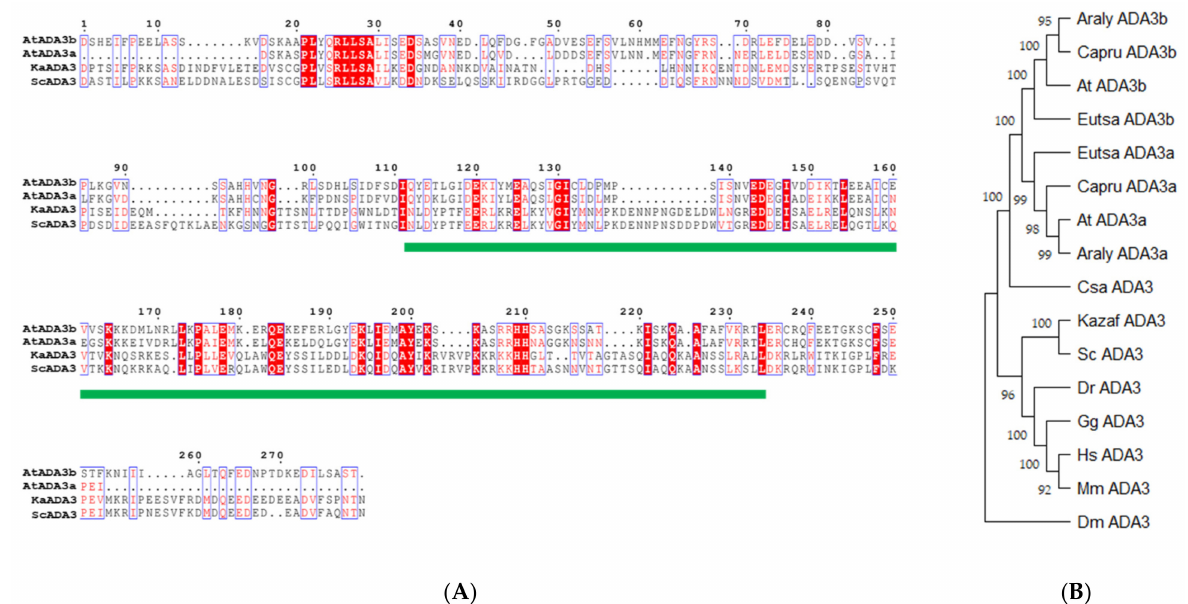
Figure 1. Alignment of ADA3 domain ( A ) and phylogenetic tree for ADA3 domain across organisms ( B ). The ADA3 domain is highlighted with a green line.